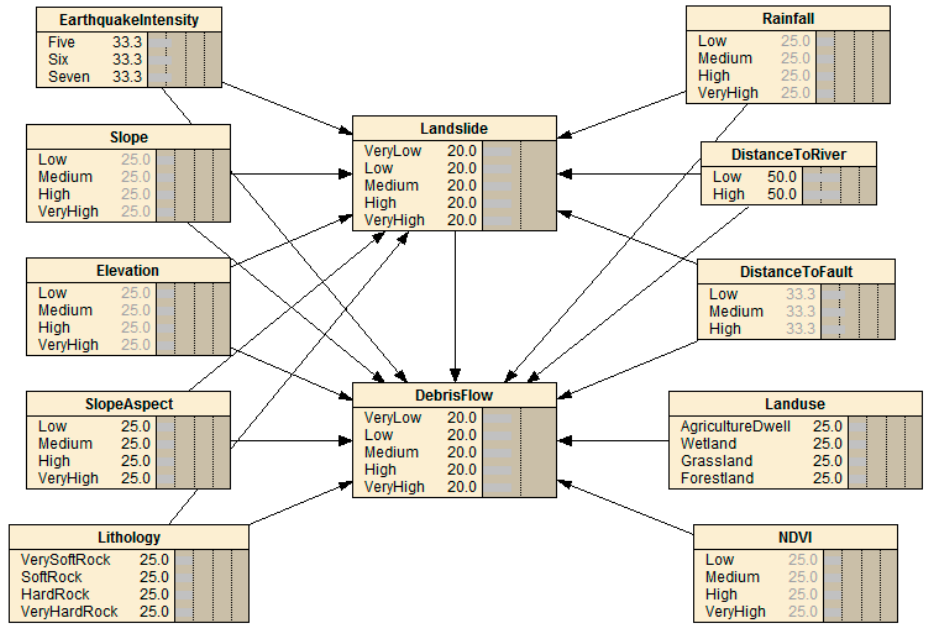
Figure 5. The Bayesian Networks model structure for an earthquake disaster chain.